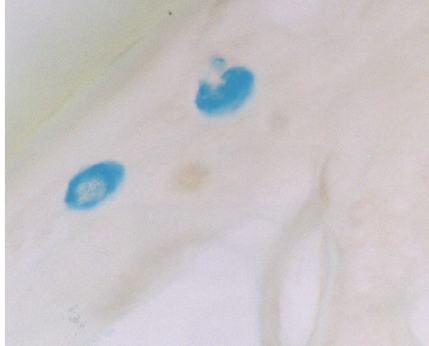
Figure 3: Testicular mast cells are observed near a damaged semi- niferous tubule. Alcian Blue technique